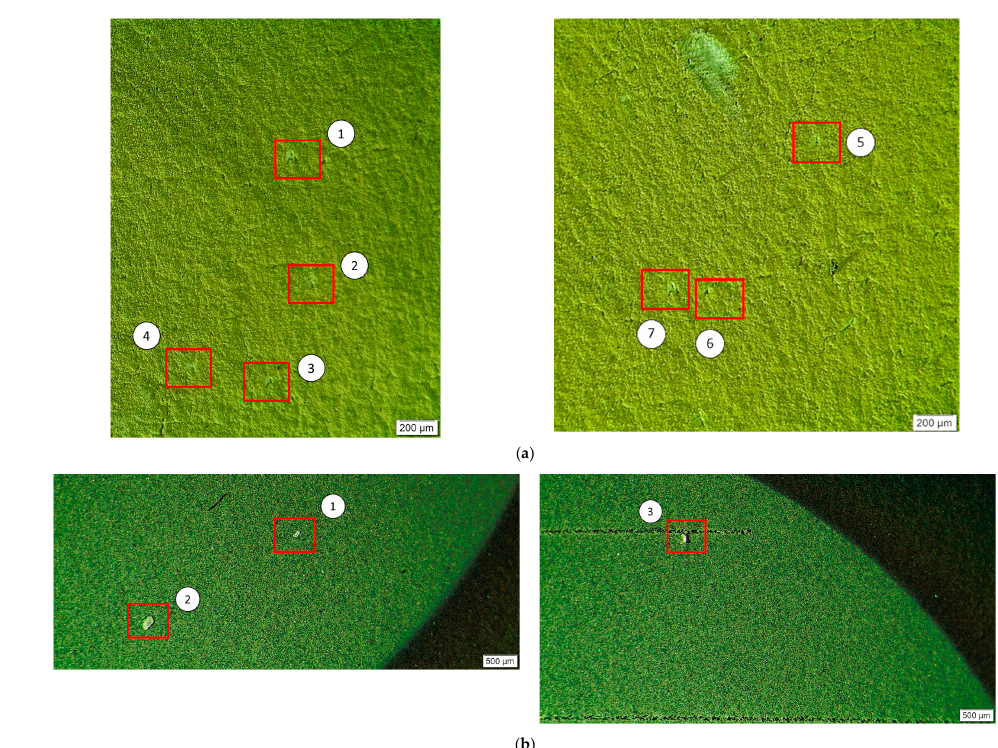
Figure 22. Flaking evidence: ( a ) PSB on CFRP-detected flaking. ( b ) PUK on aluminum.